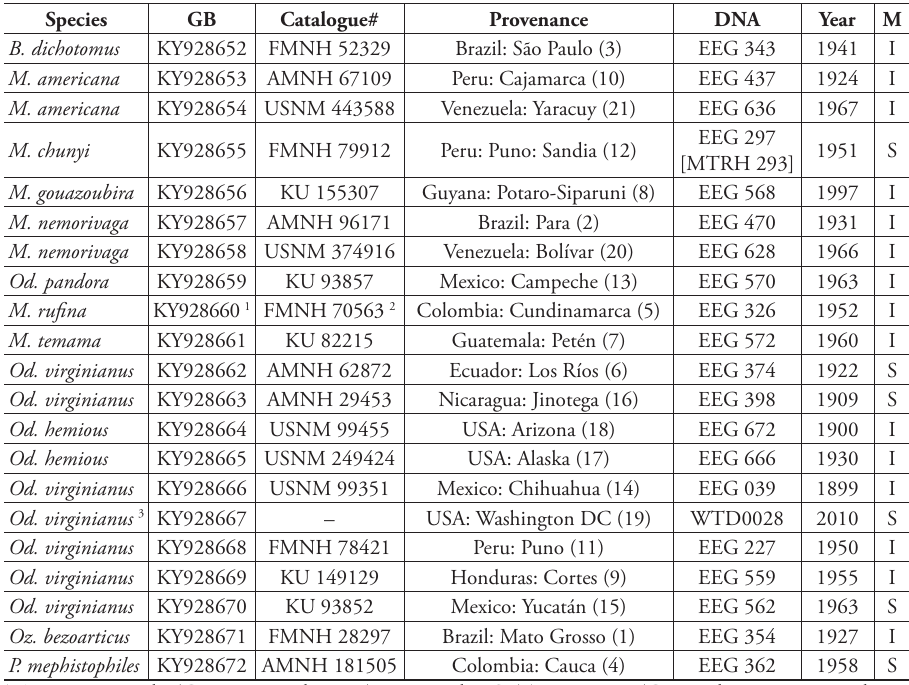
Table 1. Sequenced specimens. GB: GenBank accession number. Catalogue#: museum catalogue num- ber. Provenance: geographic origin (name of country, larger administrative entity, and a numeric identifier that corresponds to detailed locality information presented in the Gazetteer; supplementary file 1). DNA: number assigned to DNA extracted. Year: year in which the specimen was collected. M: Sequencing method (I: Illumina; S: Sanger; see